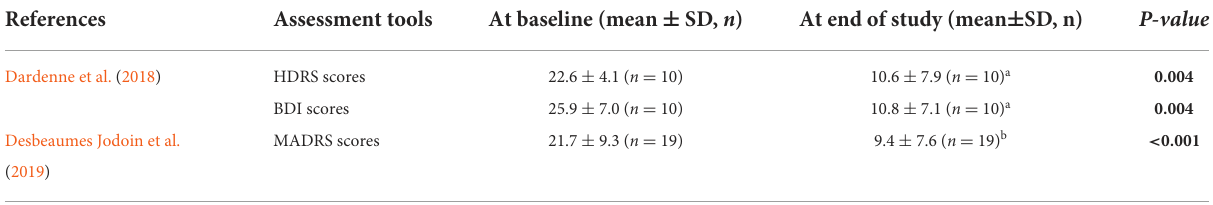
TABLE 2 The improvement of depressive symptoms after aTMS.